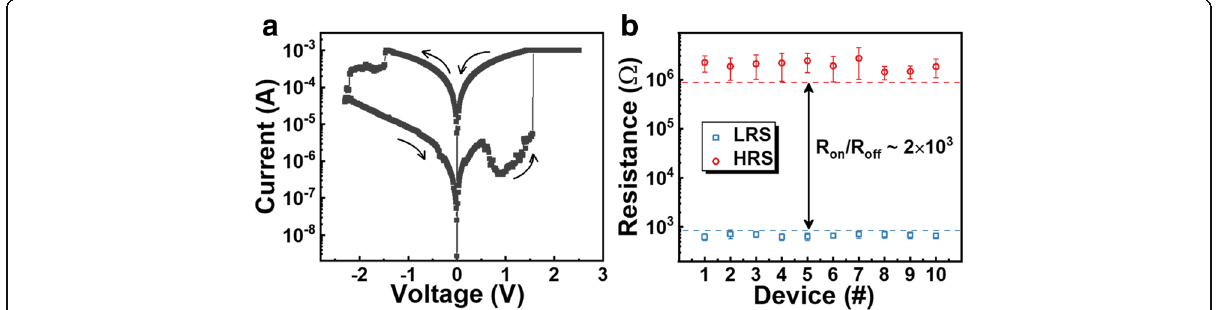
Fig. 2 a DC characteristics. b HRS/LRS statistical distributions of 10 Ru-based RRAM